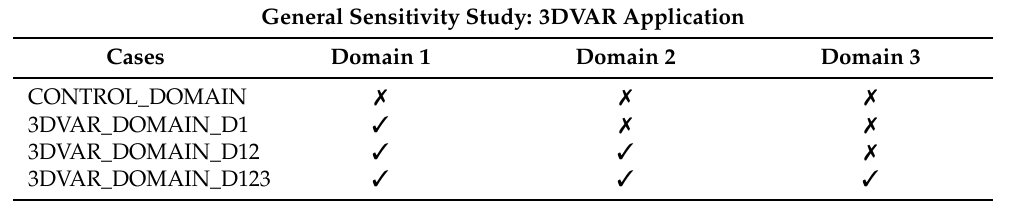
Table 2. The application of 3DVAR for the general sensitivity study. (cid:55) refers to 3DVAR not being applied and (cid:51) refers to 3DVAR being